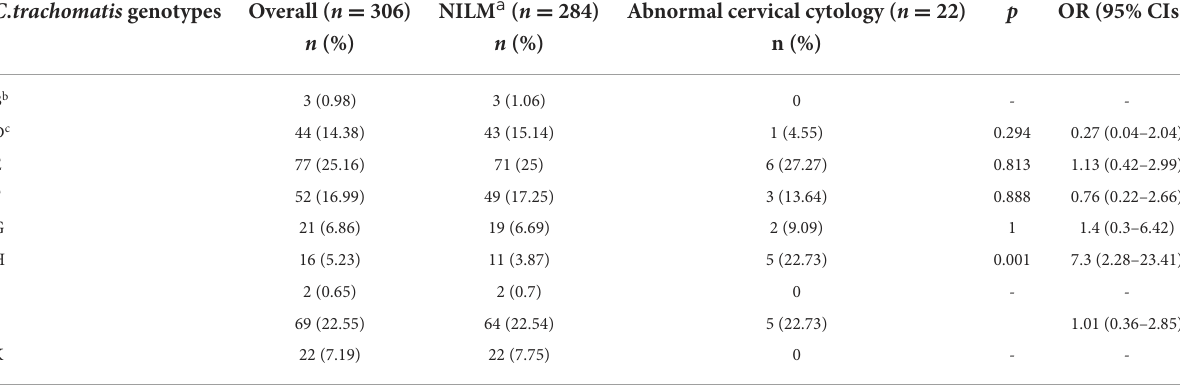
TABLE 3 The prevalence of C.trachomatis genotypes by cytology